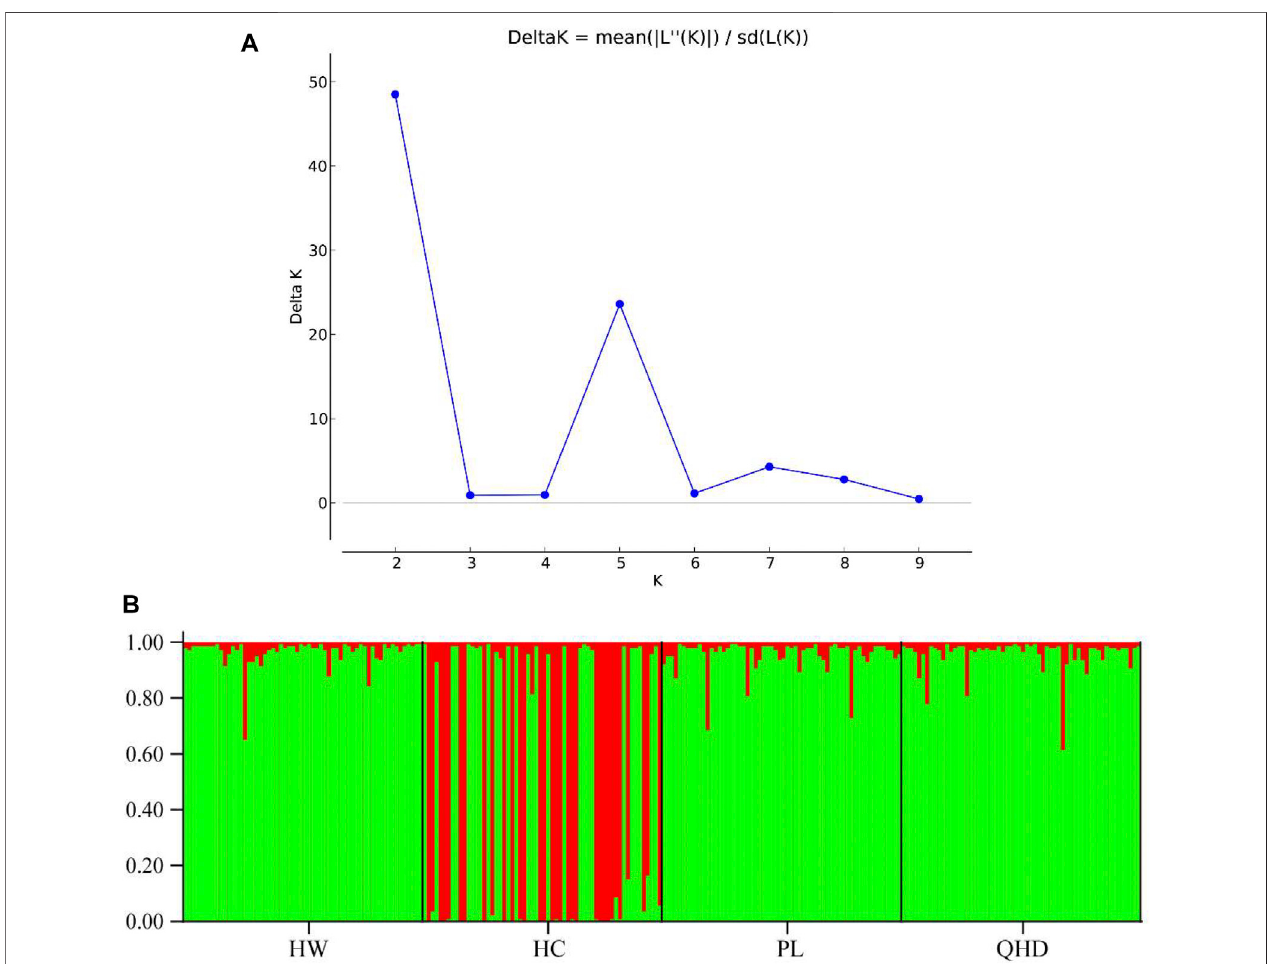
FIGURE 4 | (A) Relationships between the number of clusters (K) and the corresponding. Δ K statistics calculated based on STRUCTURE analysis. (B) Population genetic structure based on the Bayesian clustering model among 240 P. trituberculatus samples at K = 2.